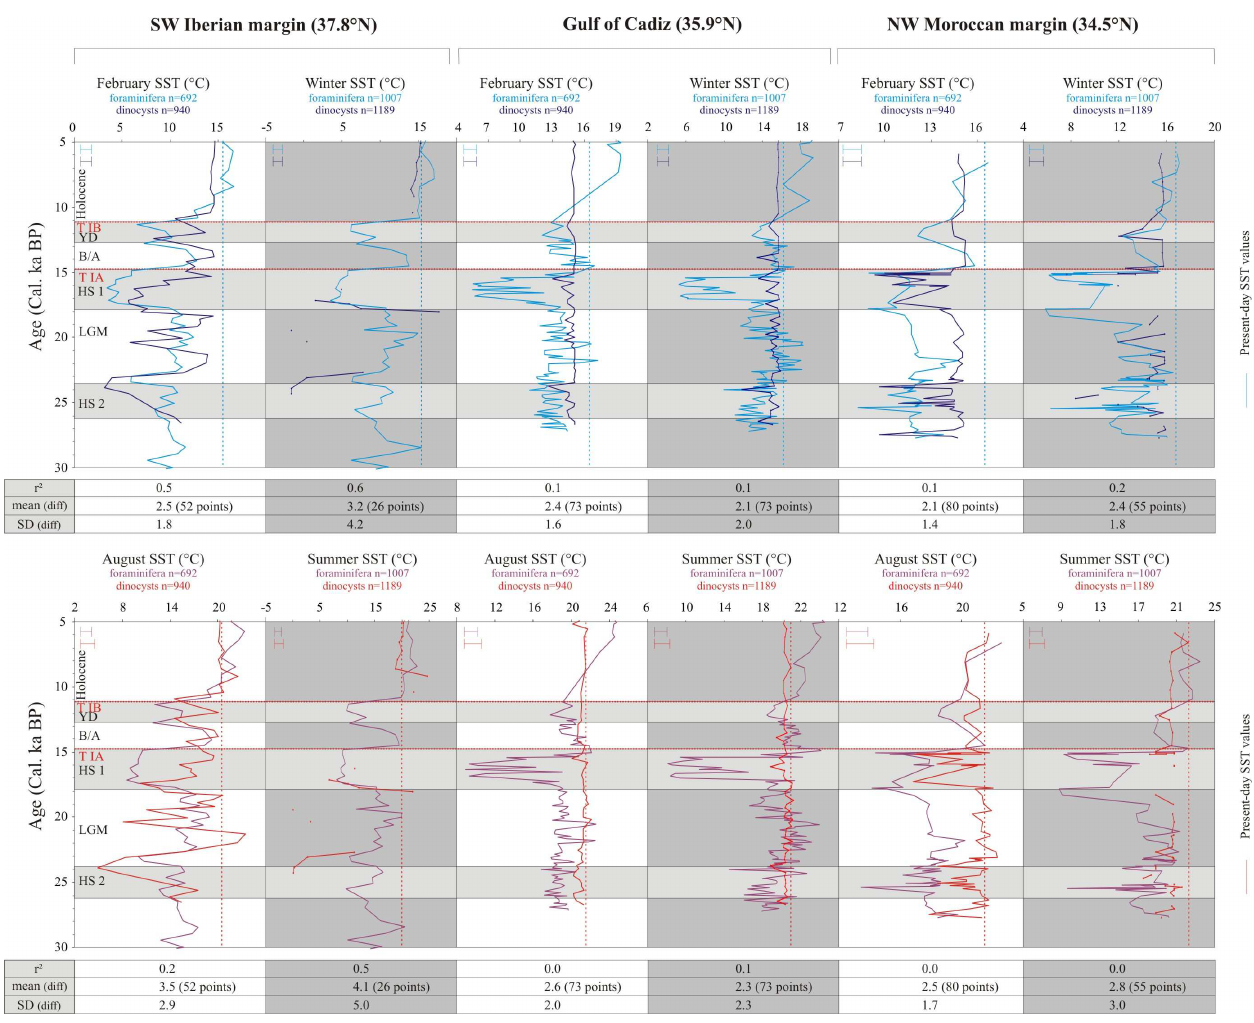
Fig. 5. Comparison of foraminiferal versus dinocyst SST reconstructions: February and August (PaleoToolBox-692-foraminifera versus 3PBase-940-dinocysts), winter and summer (R-1007-foraminifera versus R-1189-dinocysts). Error bars are shown for the different recon- structions. Tables under the graphs show the correlation coefficient between each reconstruction, and the average (mean-diff) and standard deviation (SD-diff) of the differences calculated between each reconstruction. YD: Younger Dryas; B/A: B¨olling-Allerød; HS: Heinrich Stadial; LGM: Last Glacial Maximum; TI: Termination